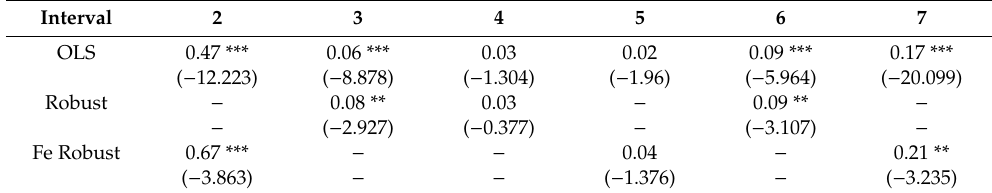
Table 6. Turnover Ratio’s Coe ffi cient after Robust used to Rectify the problem in Data. Interval